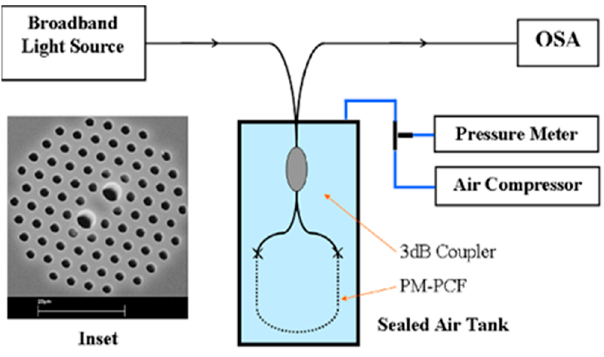
Figure 12. Schematic diagram of the proposed pressure sensor constructed with a polarization-maintaining PCF-based Sagnac interferometer. Inset consist used a polarization-maintaining PCF (Reproduced from [58], with the permission of OSA publishing).